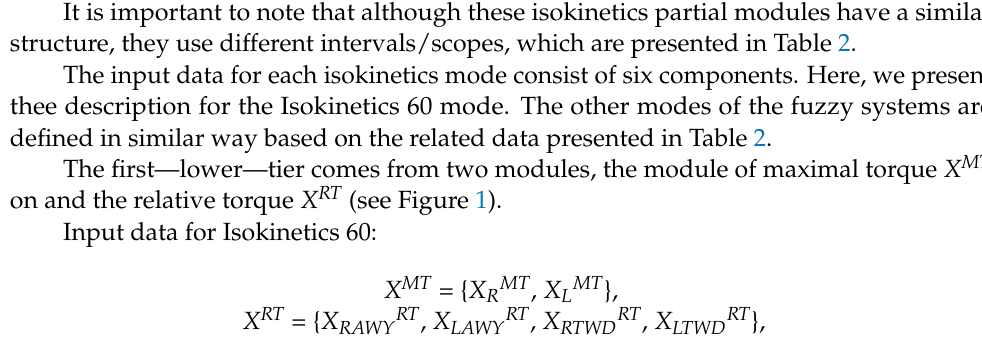
Figure 1. The structure of the hierarchy of fuzzy system.